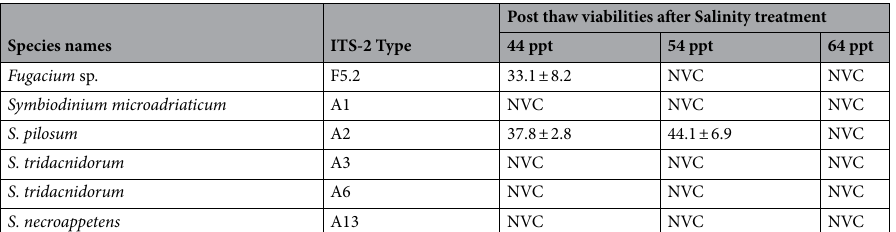
Table 5. Cell viabilities after controlled-rate freezing with salinity treated culture isolates using 15% Dimethyl sulfoxide (DMSO) as the cryoprotectant agent (CPA). Values are mean percentage of three replicates (n = 3) ± standard deviation (SD) of the mean. NVC no viable cells